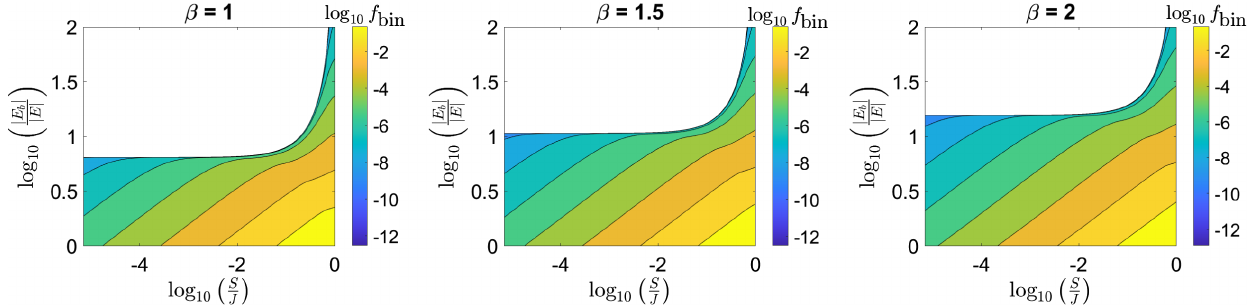
FIG. 9. Plots of Eq. (34) for m 1 ¼ m 2 ¼ m 3 for different values of β : β ¼ 1 (left), β ¼ 1 . 5 (center), and β ¼ 2 (right). One can see that except for at energies where f is minuscule anyway, the three plots agree well with each bin